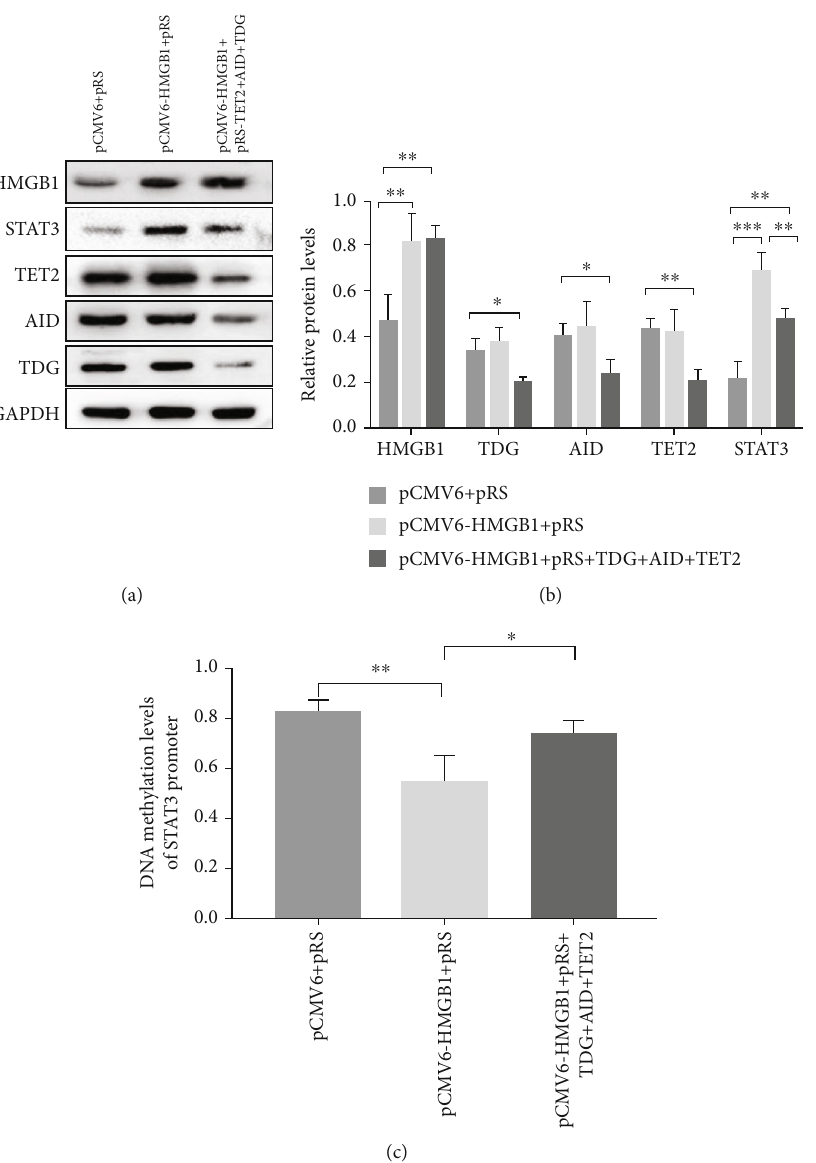
Figure 5: The overexpression of STAT3 induced by HMGB1 could be partially disrupted in CD4 + T cells transfected with the TET2/AID/TDG interference plasmid. (a) Representative western blot results for HMGB1, TDG, AID, TET2, STAT3, and GAPDH levels. (b) Quantitative analysis of the relative protein levels of HMGB1, TDG, AID, TET2, and STAT3. (c) DNA methylation levels of STAT3 promoter in CD4 + T cells transfected with di ff erent plasmids (control plasmids; HMGB1 overexpression plasmids; HMGB overexpression plasmids and TET2/AID/TDG interference plasmids); ( 0 = unmethylated , 1 = methylated ). Data are presented as the mean ± SD of three independent experiments. ∗ p < 0 : 05 , ∗∗ p < 0 : 01 , ∗∗∗ p < 0 : 001